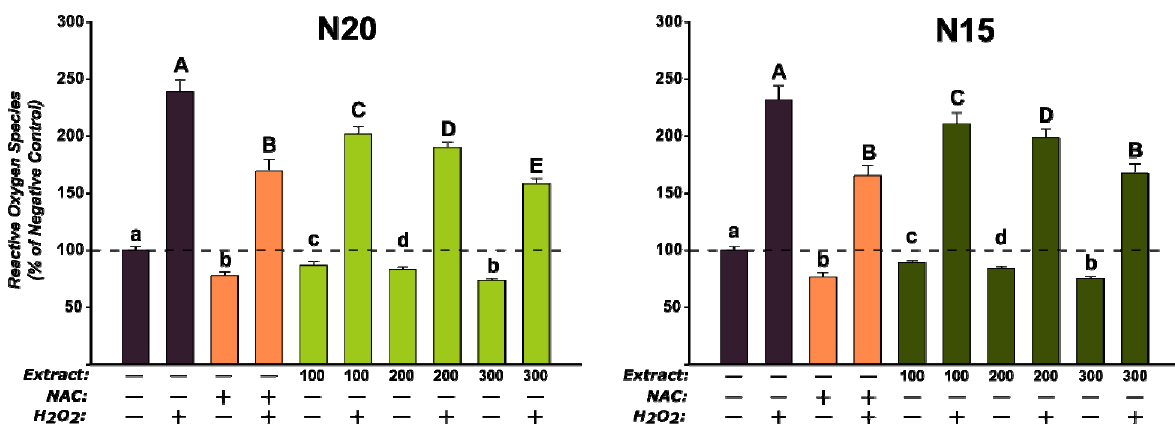
Figure 10. Antioxidant effects of the Juglans sp. extracts (N20, N15) using the DCFH-DA assay on normal BJ cells after 24 h exposure. The results are presented as relative mean values ± standard deviations, where the negative control (NC) is 100%. Different letters (a–e refer to comparisons on non-H 2 O 2 stimulated conditions, whereas A–E refer to comparisona on stimulated conditions) indicate significant differences (ANOVA + Holm–Sidak post hoc test at p < 0.05).